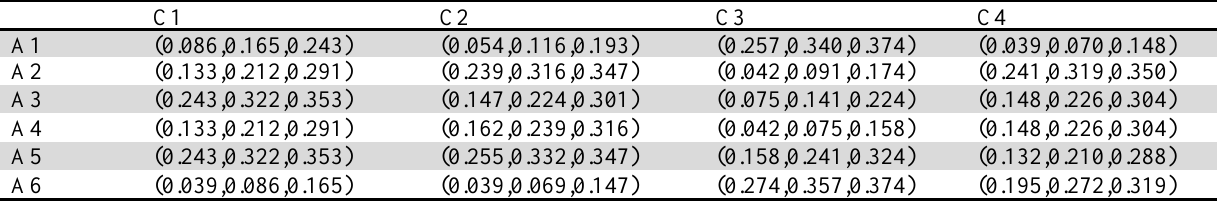
Normalized fuzzy decision matrix for